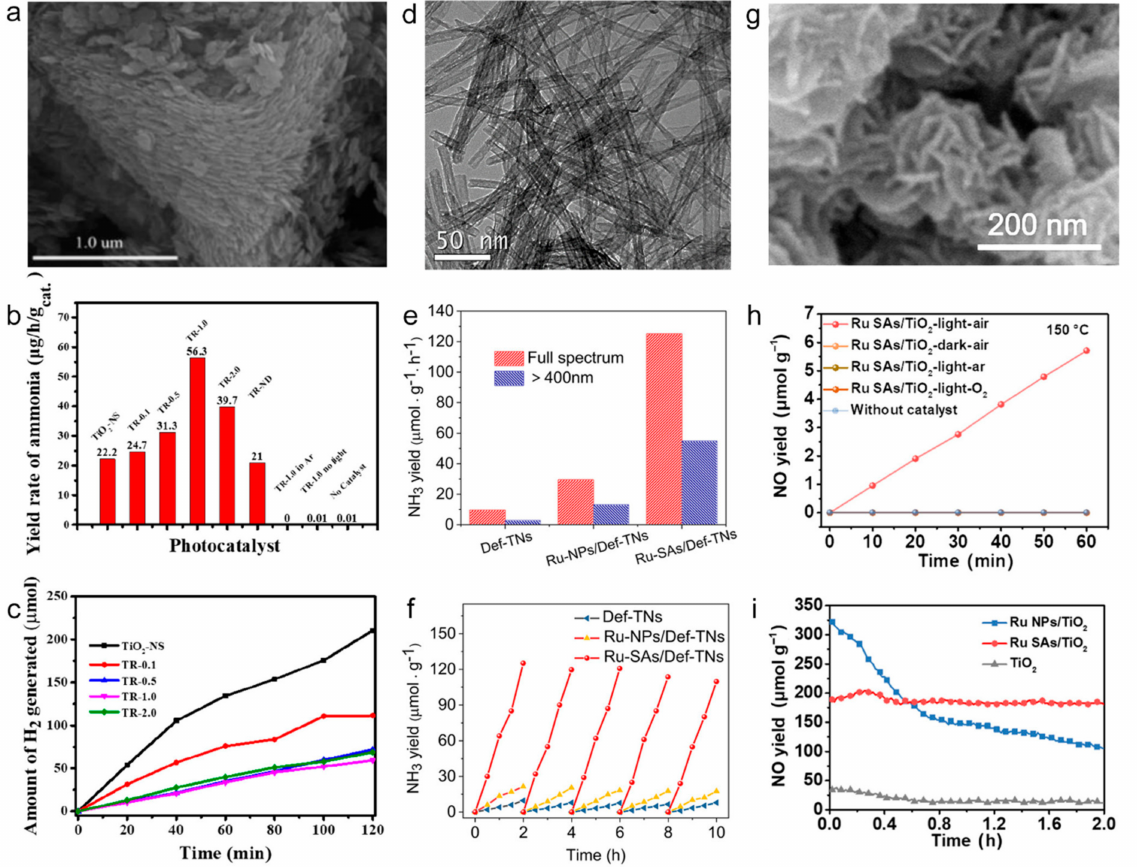
Figure 13. ( a ) SEM image of TiO 2 nanosheets. ( b ) The yield rates of ammonia and ( c ) the amounts of H 2 generated over TiO 2 nanosheets with various amounts of Ru. Adapted with permission from Ref. [44]. ( d ) HRTEM images of Def-TNs, ( e ) Comparison of the total NH 3 yields in the first 2 h under full-spectrum or visible-light ( λ > 400 nm) irradiation, and ( f ) Quantitative determination of the NH 3 yields as a function of irradiation time under full-spectrum irradiation (300 W Xe lamp) and five cycling tests for the three samples, i.e., Def-NTs, Ru NP/Def-NTs and Ru SA/Def-NTs. Adapted with permission from Ref. [42]. ( g ) SEM image of Ru SAs/TiO 2 . ( a ) TEM ( h ) Performances and verification experiments of NO production via the photo-oxidation of N 2 over Ru SAs/TiO 2